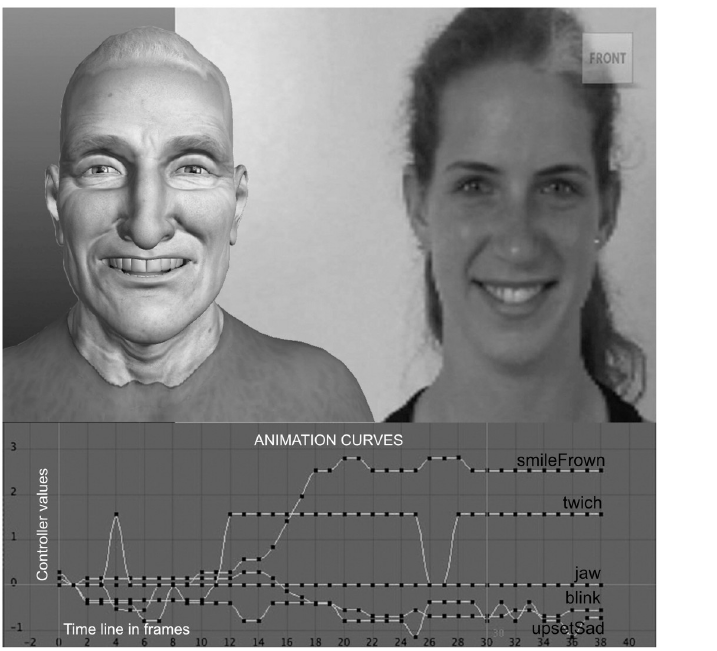
Fig 6. Mapping data for expression open-mouth smile to a virtual character.